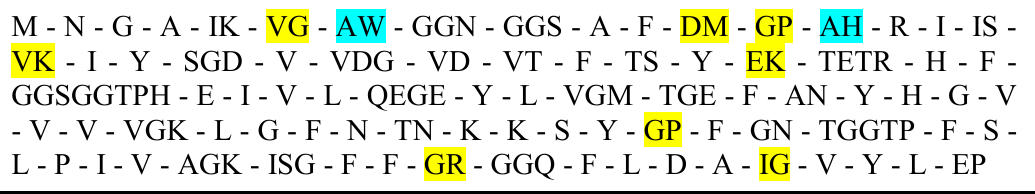
Figure 3. Representation of the cleavage sites (-) of pepsin, trypsin, chymotrypsin and thermolysin in the lectin protein sequence with the peptides highlighted are known to exhibit ACE inhibitory activity and/or antioxidant activity. Yellow highlight for ACE inhibitor peptides and blue highlight for both ACE inhibitor and antioxidant peptides.